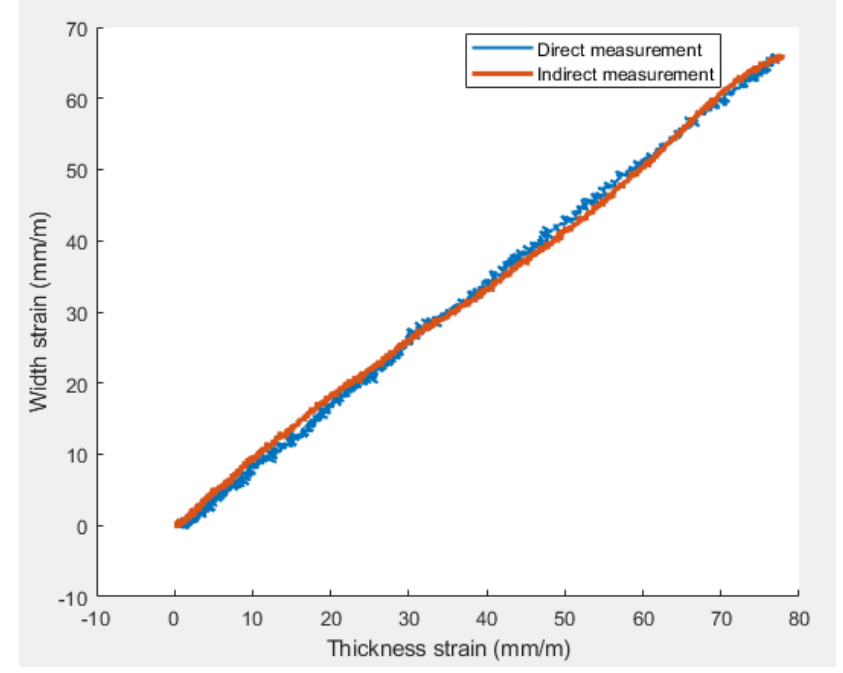
Figure 13. The R - value curve by two different measurement methods in the non-necking area.